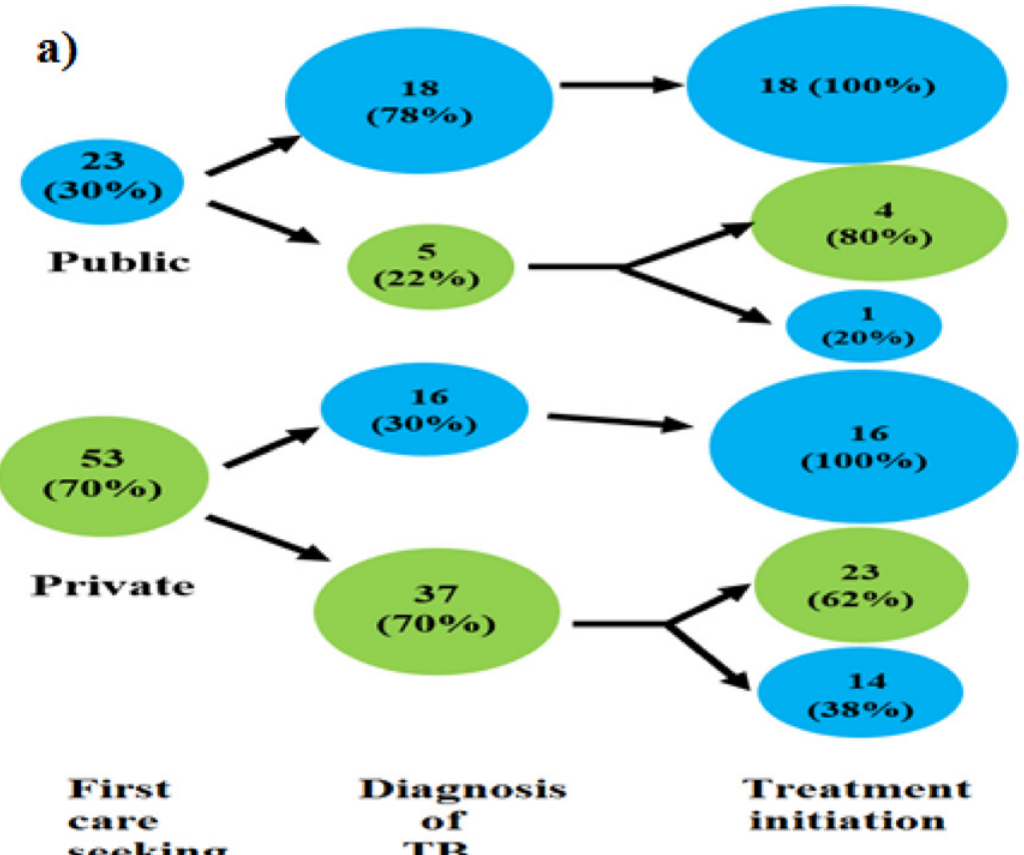
Fig 5. Provider switching at different stages of the TB patient care pathway: a) between public and private sector; b) between allopaths and non-allopaths † . The figures depict the patient behaviour in seeking TB care at different stages of the pathway and preference for accessing the public or the private sector, and allopaths or